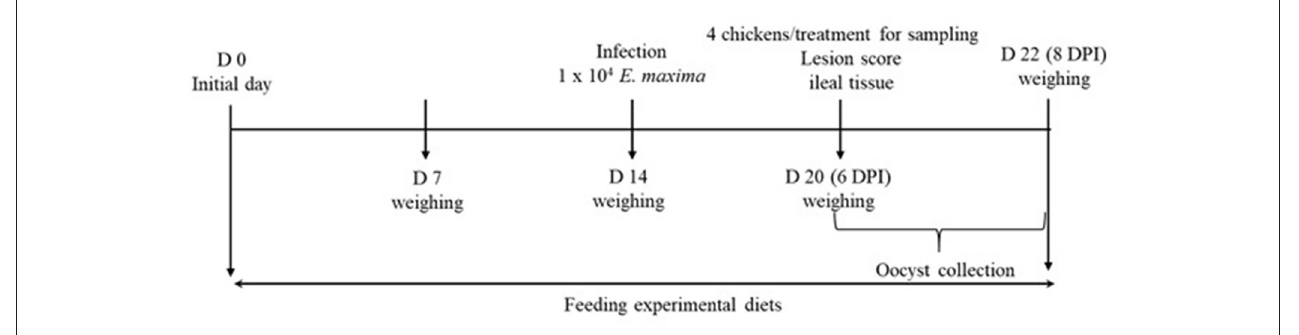
FIGURE 1 | Schematic outline of the experimental design in experiment 2.